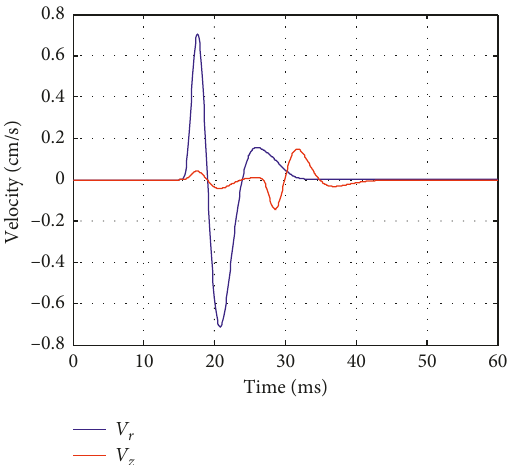
Figure 8: Typical blast vibration velocity waveform computed by the seed wave-based superposition model, where V r and V z are, respectively, the horizontal and vertical velocities.